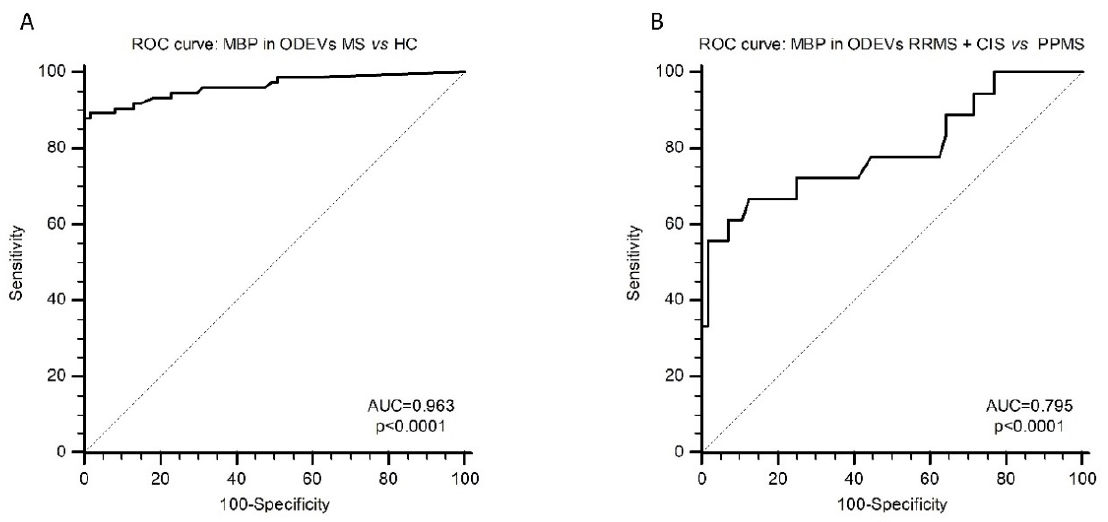
Figure 3. ROC curve analysis. ( A ): ROC curves of MBP in enriched ODEVs: HC vs. MS (CIS + RRMS + PPMS). AUC and p value are reported. ( B ): ROC curves of MBP in enriched ODEVs: PPMS vs. (CIS + RRMS). AUC and p value are reported.